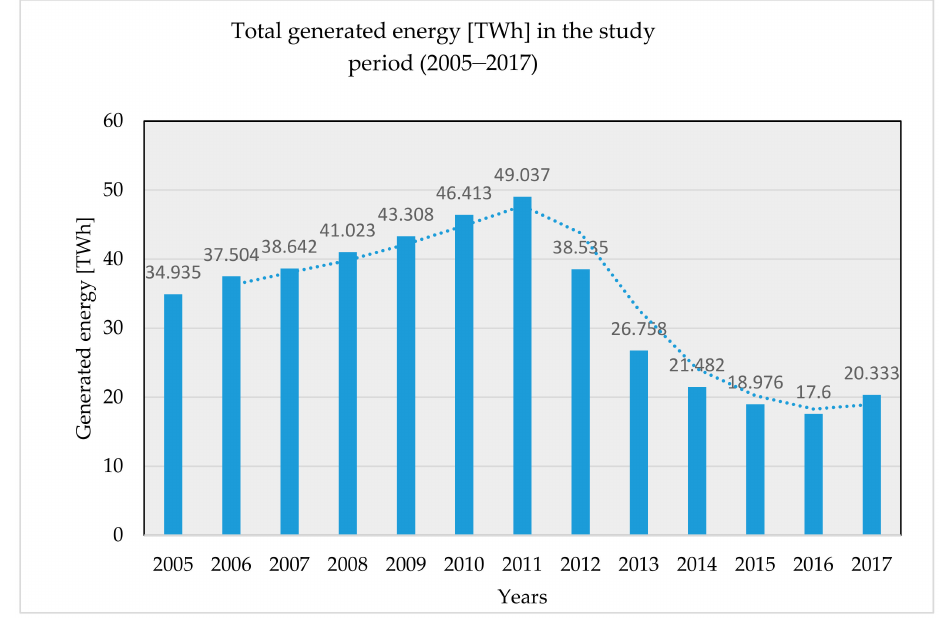
Figure 10. Generated energy in the study period